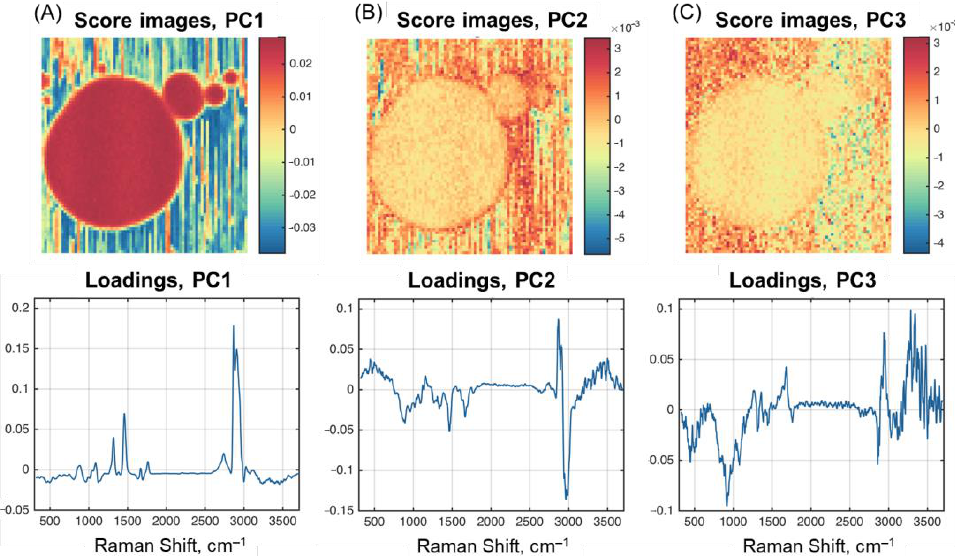
Figure 4. PCA scores and loadings for Sample F1: ( A ) PC1; ( B ) PC2; ( C )